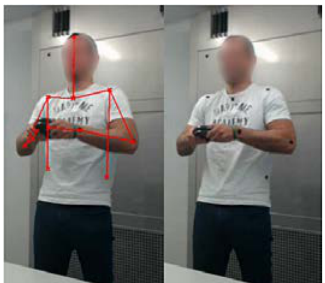
Figure 1. Body Segments and markers